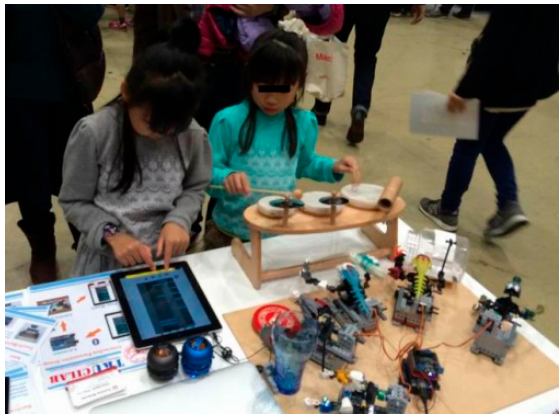
Figure 11. Field trials of our system at Maker Faire Tokyo.